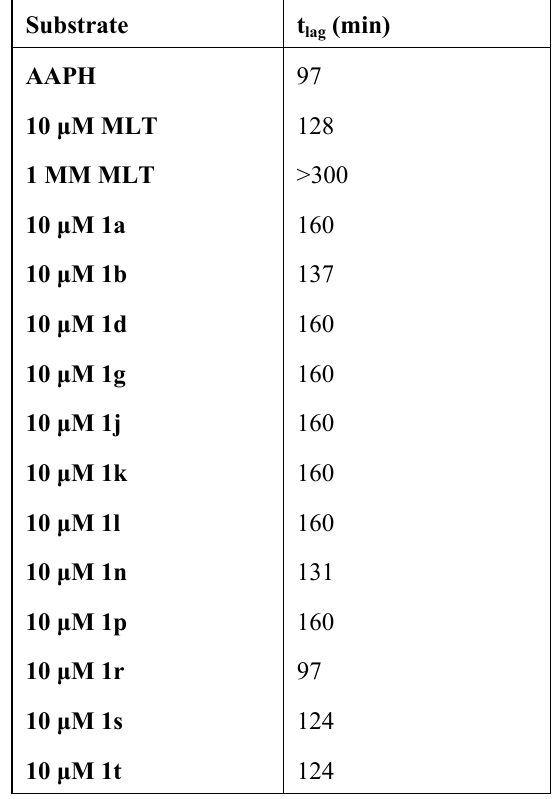
Table 1. Quantitative indicator measured from AAPH-induced erythrocyte hemolytic curves. Values are the means of data obtained from three separate curves. Data represent mean of three different curves for each compound. tlag; lag time before the starting of